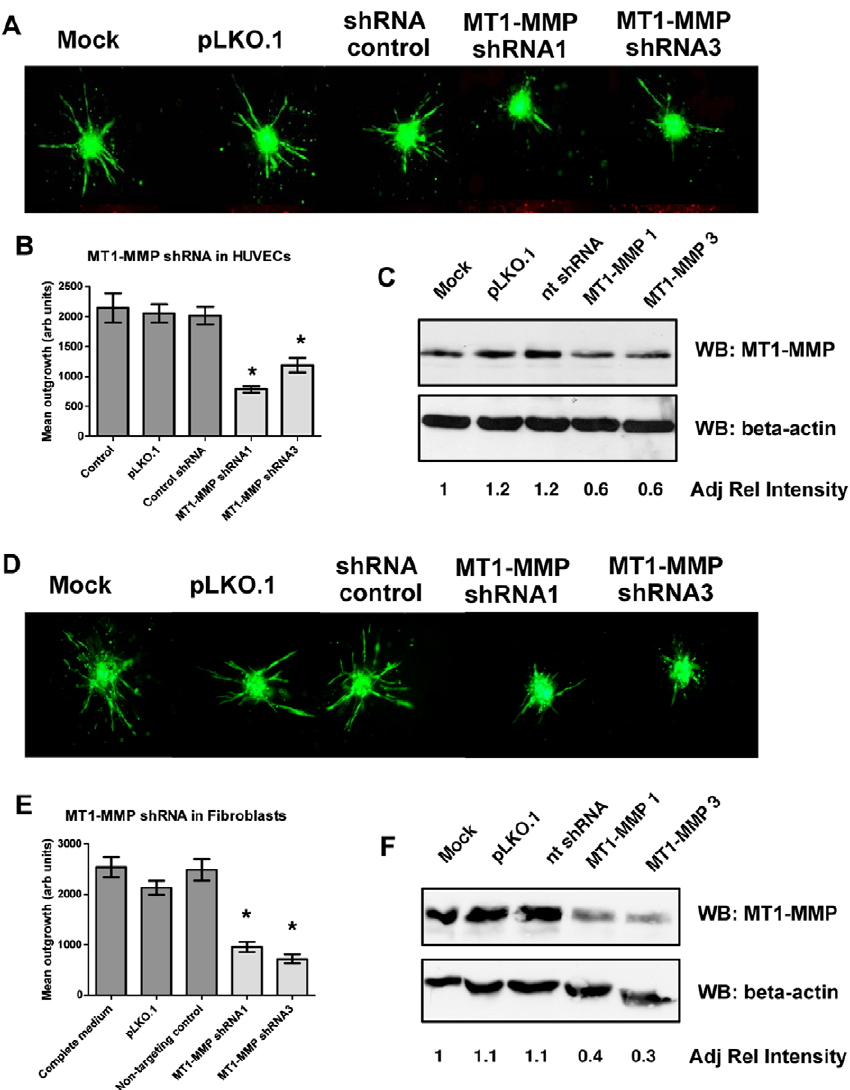
Figure 6. MT1-MMP gene silencing in both HUVECs and fibroblasts decreases endothelial sprout formation. Cells were infected with lentiviral particles expressing 2 different shRNAs against MT1-MMP, selected with puromycin and used to make spheroids. A – Representative images of pre-dyed endothelial cell sprouting from Minitumour spheroids made with HUVECs transduced with the different lentiviral derived shRNAs and controls. B – Quantification of endothelial cell sprouting showing a decrease in sprout formation with HUVECs expressing MT1-MMP shRNAs. C - Western Blots confirming MT1-MMP knock down levels of about 50% in HUVECs, adjusted relative intensity was determined through the ImageJ software follwed by normalization against the loading and mock controls. D – Representative images of pre-dyed endothelial cell sprouting from Minitumour spheroids made with Fibroblasts transduced with different lentiviral derived shRNAs and controls. E – Quantification of endothelial cell sprouting showing a decrease in sprout formation with from Minitumour spheroids with Fibroblasts expressing MT1-MMP shRNAs. F - Western blots confirming MT1-MMP knock down levels of about 30% in the fibroblasts, adjusted relative intensity was determined through the ImageJ software followed by normalization against the loading and mock controls.